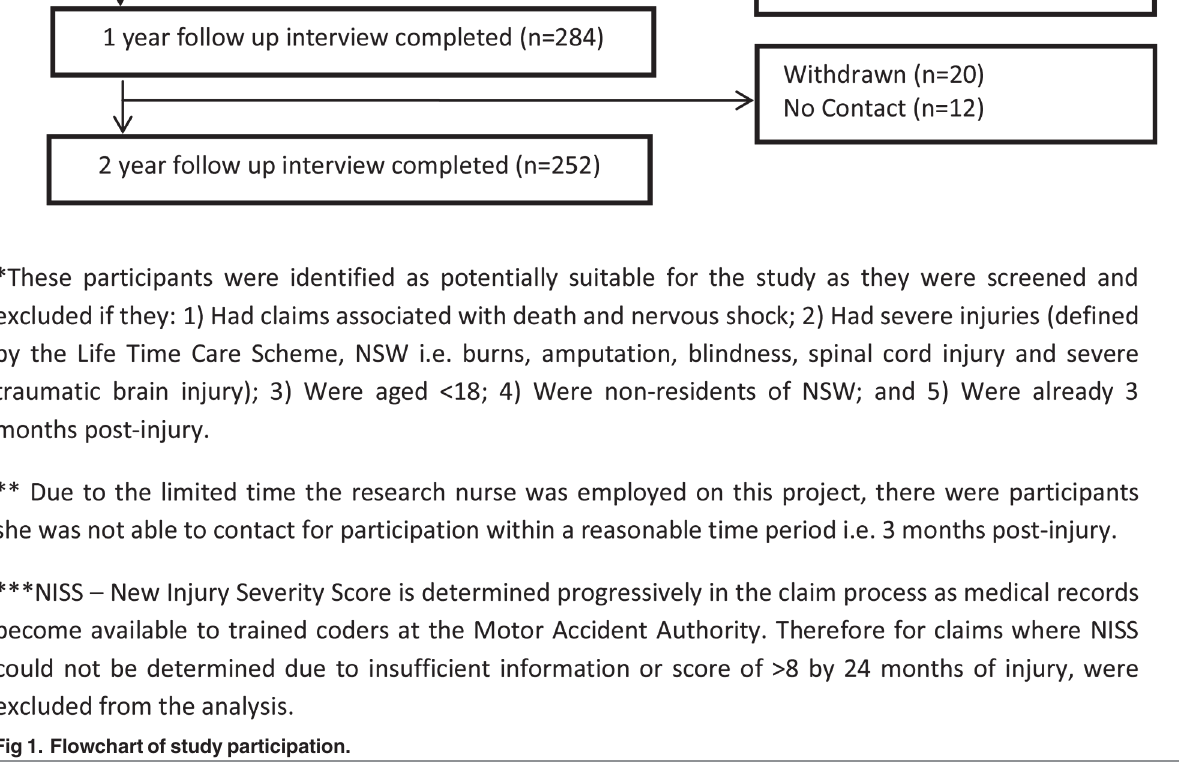
PLOS ONE | DOI:10.1371/journal.pone.0122732 April 1,